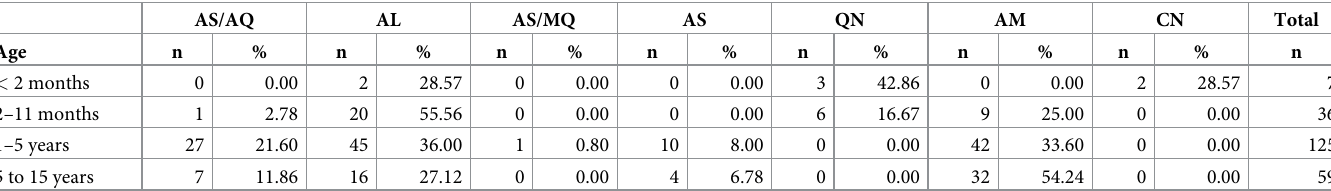
Table 1. Treatment administered by patient